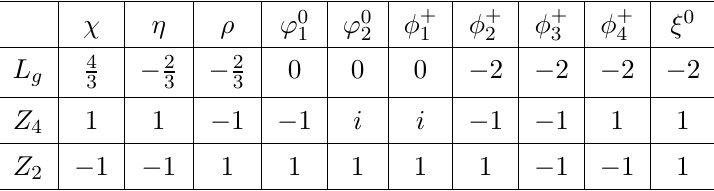
Table 3 . Scalar assignments under Z 4 (cid:2) Z 2 and the values of generalized Lepton Number L g